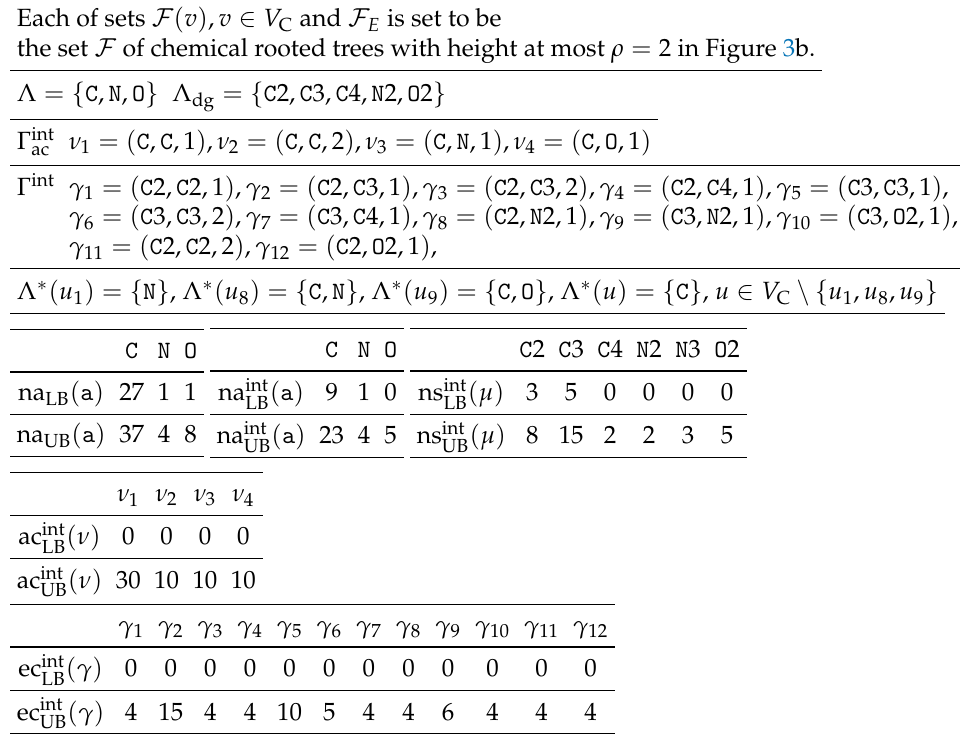
Table 2. Example 2 of a chemical-specification σ ce